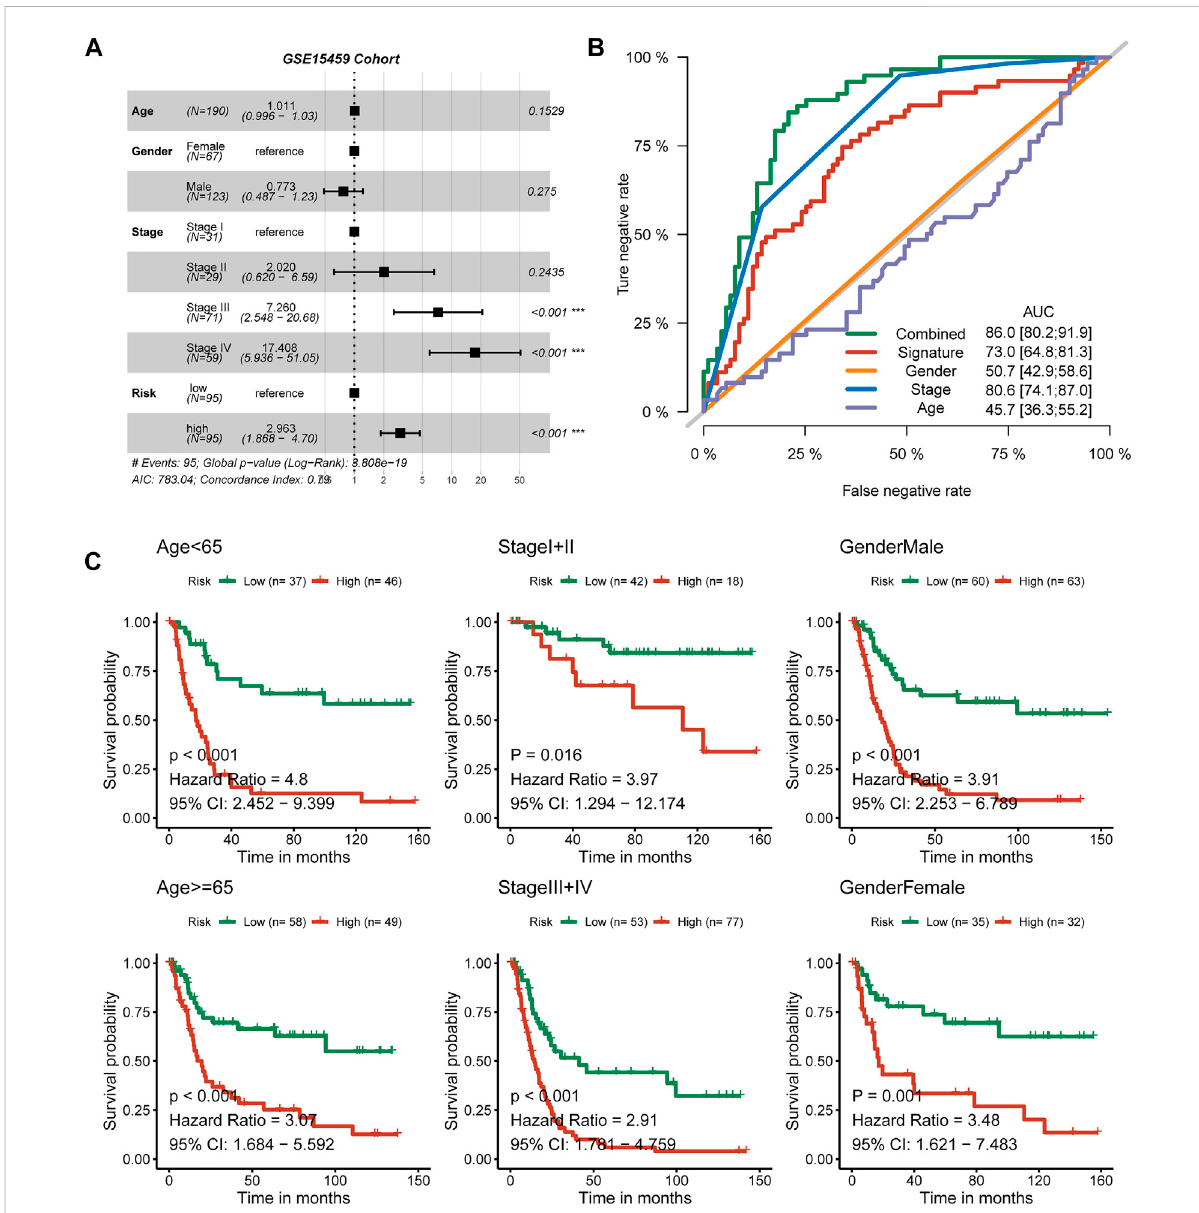
FIGURE 5 The nine-consensus-prognostic-gene signature is an independent prognostic factor for GCpatients. (A) , Forestplot showing thehazard ratios from multivariate Cox regression analysis in the GSE15459 cohort; (B) , ROC curves showing the prognostic ef fi ciency of the signature, clinical parameters and combined model; (C) , The prognostic value of the signature in clinical